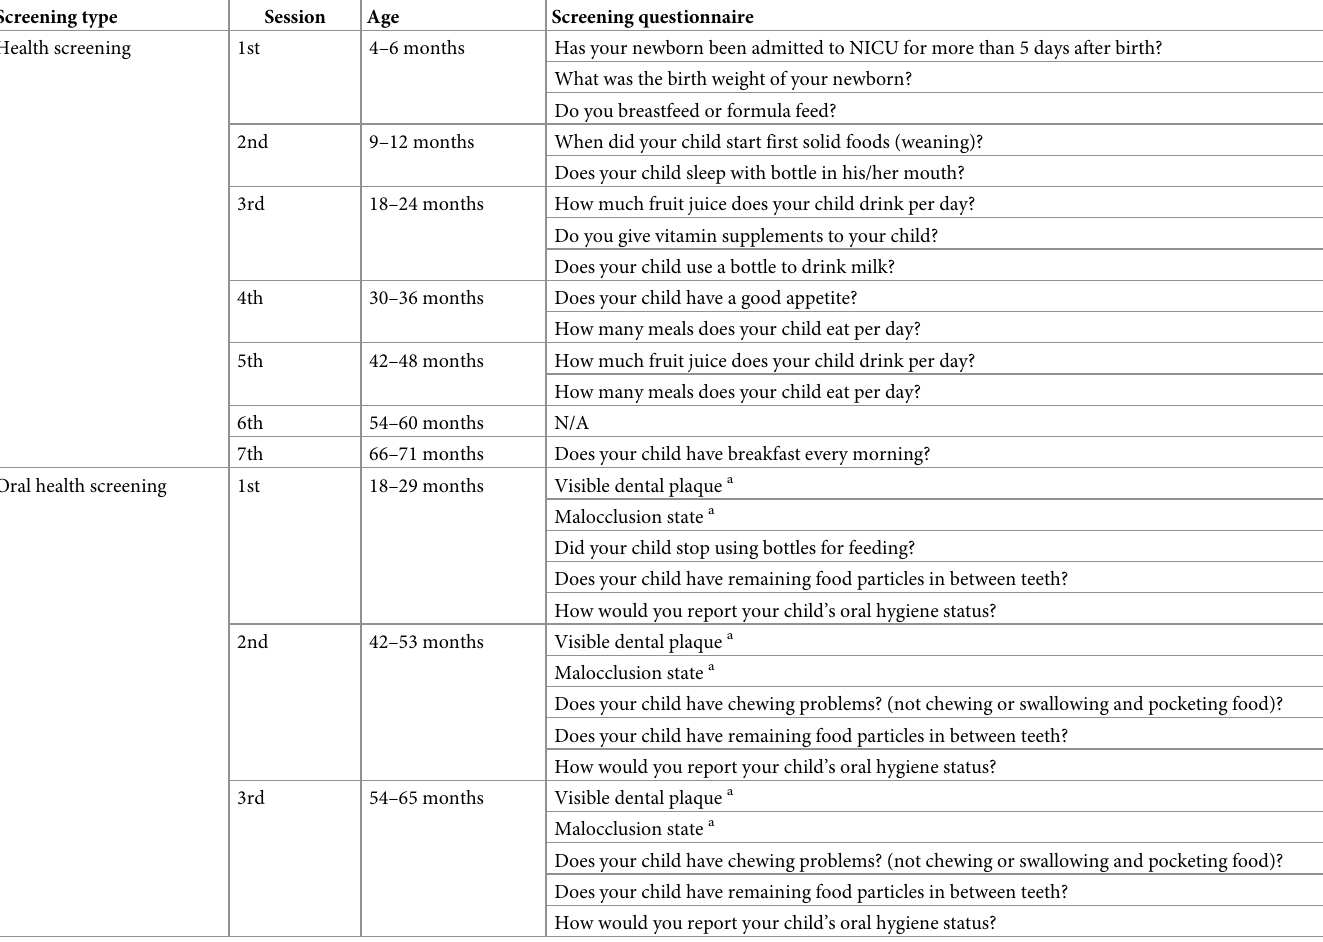
Table 1. Health and oral health screening questionnaire responses. Screening